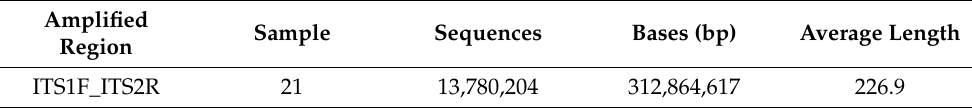
Table 1. The optimized sequence information obtained via fungal high-throughput sequencing.